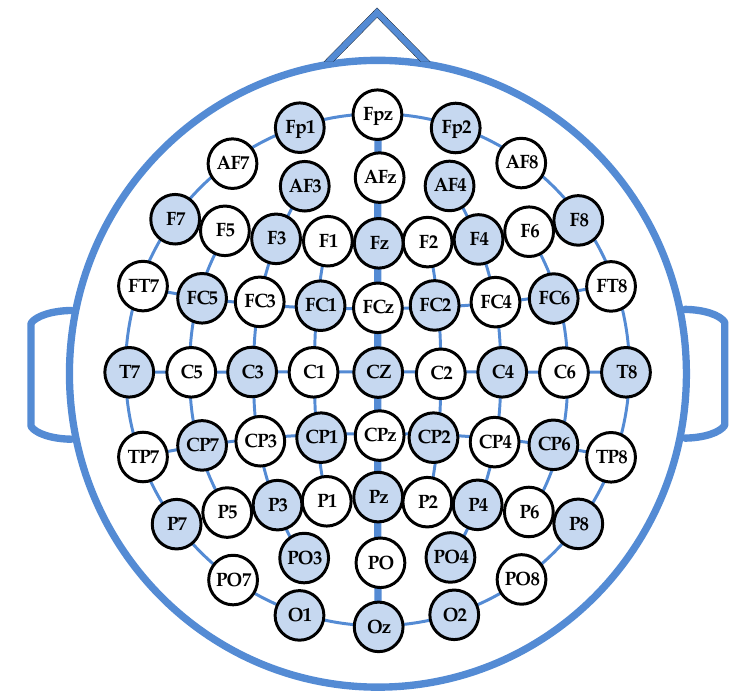
Figure 3. International 10-20 system for 32 electrodes (marked with blue circles).